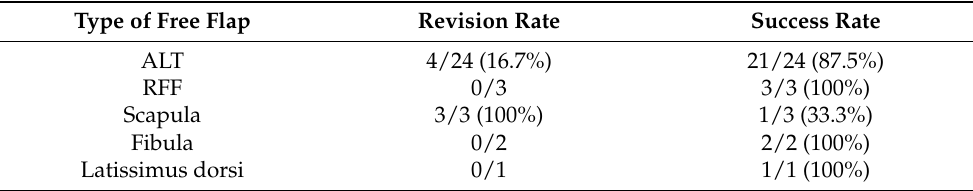
Table 3. Overview on free flaps used for the restoration of full-thickness defects with revision and success rates.